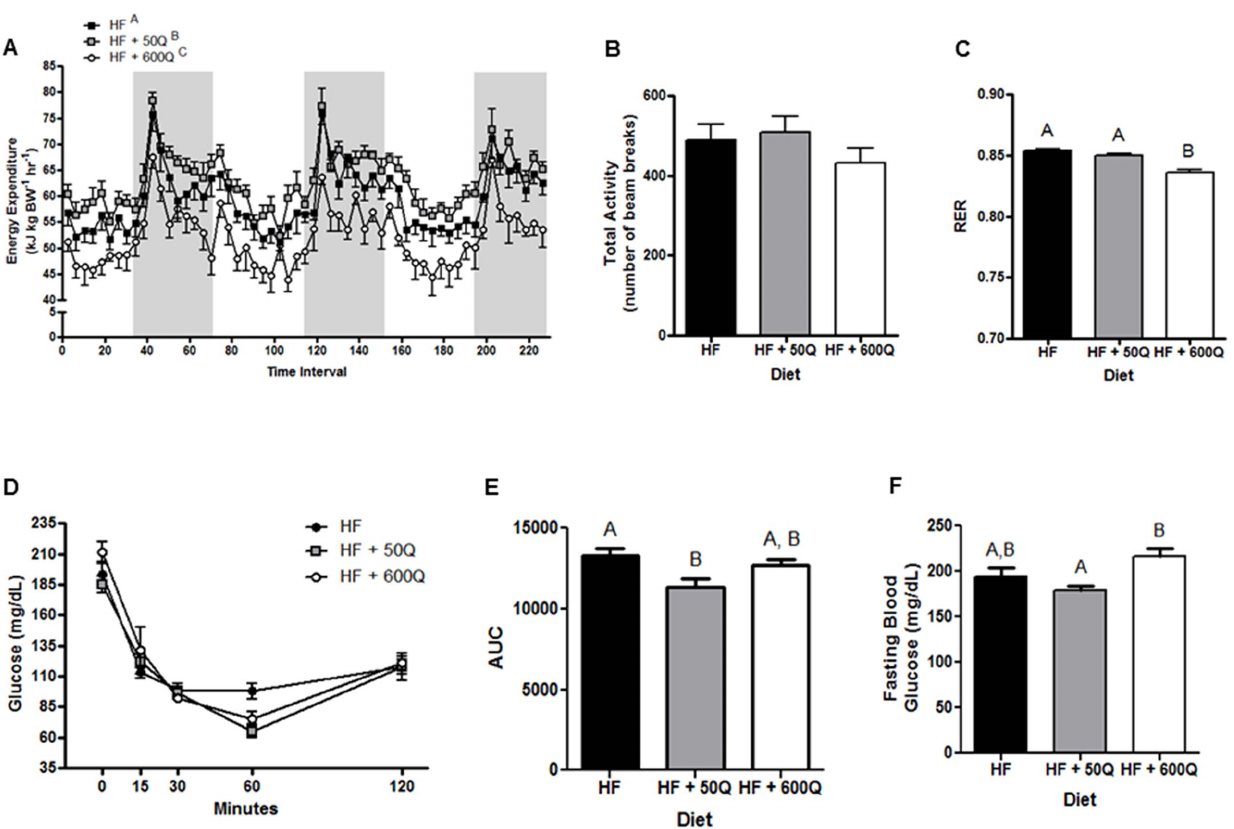
Figure 3. After 8 wks of feeding respective diets, energy expenditure (A), physical activity (B) and respiratory exchange ratio (RER) (C) were measured by indirect calorimetry. Gray bars represent night periods in A. Insulin sensitivity was assessed by an insulin tolerance test after 8 wks on respective diets and is shown as the average blood glucose levels before, and at 15, 30, 60 and 120 mins after injection of insulin ( D ) and as the average area under the curve (AUC) for each treatment group ( E ). ( F ) Fasting blood glucose levels are also reported. All values are shown as the mean 6 SEM. Significant differences between groups are denoted by differing superscripts.